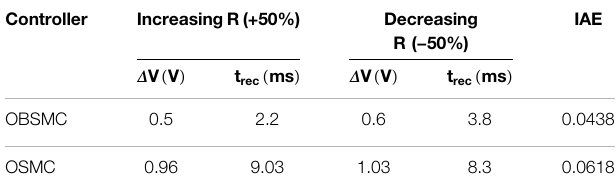
TABLE 4 | Performance speci fi cation of the converter related to load resistance